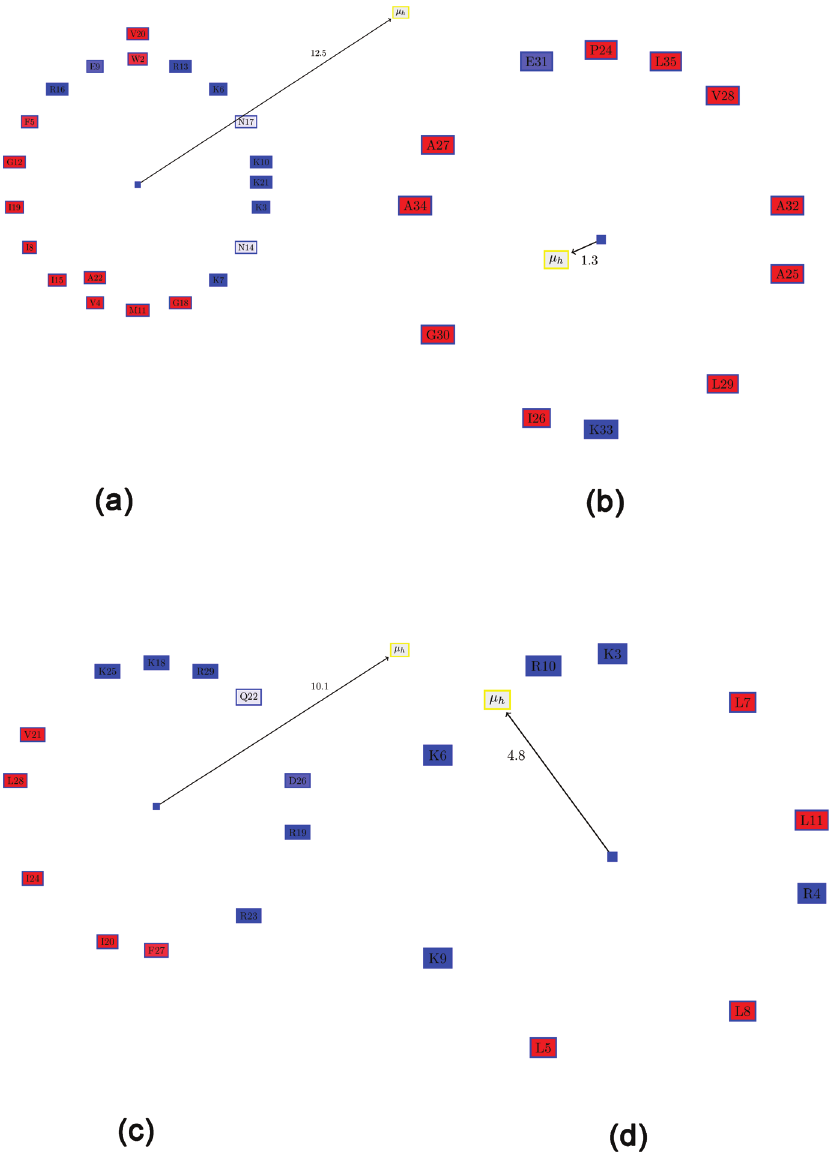
Figure 3. Visualizing the Edmundson wheel and hydrophobic moment of some alpha helices. All hydrophobic residues are colored in red, while hydrophilic residues are colored in blue: dark blue for positively charged residues, medium blue for negatively charged residues and light blue for amides. ( a ) N-Terminal helix of cecropin B. ( b ) C-Terminal helix of cecropin B. ( c ) KR-12 peptide fragment from cathelicidin LL-37. ( d ) De novo designed peptide (SP1-1) with anti-microbial